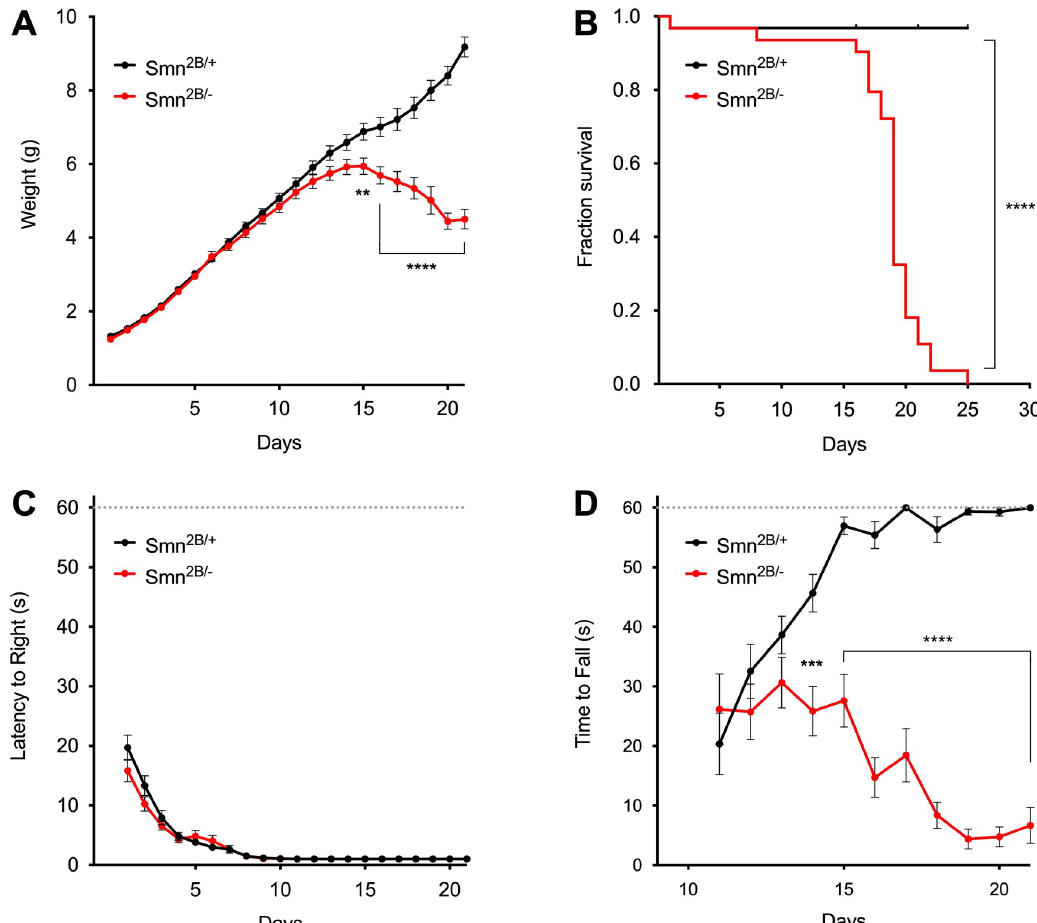
Fig 1. Behavioral characterization of Smn 2B/- SMA mice. (A) Body weight of control Smn 2B/+ (n = 32) mice and Smn 2B/- SMA mice (n = 31). Data represent mean and SEM. Statistics were performed with two-way ANOVA and Bonferroni’s multiple comparison test. �� P < 0.01; ���� P < 0.0001. (B) Kaplan-Meier survival curves from the same experimental groups as in (A). Statistics were performed with Log-rank (Mantel-Cox) test. ���� P < 0.0001. (C) Righting time from the same experimental groups shown in (A). Data represent mean and SEM. Statistics were performed with two-way ANOVA and Bonferroni’s multiple comparison test. Not Significant. (D) Time to fall in the hindlimb suspension test from the same experimental groups shown in (A). Data represent mean and SEM. Statistics were performed with two-way ANOVA and Bonferroni’s multiple comparison test. ��� P < 0.001; ���� P < 0.0001.